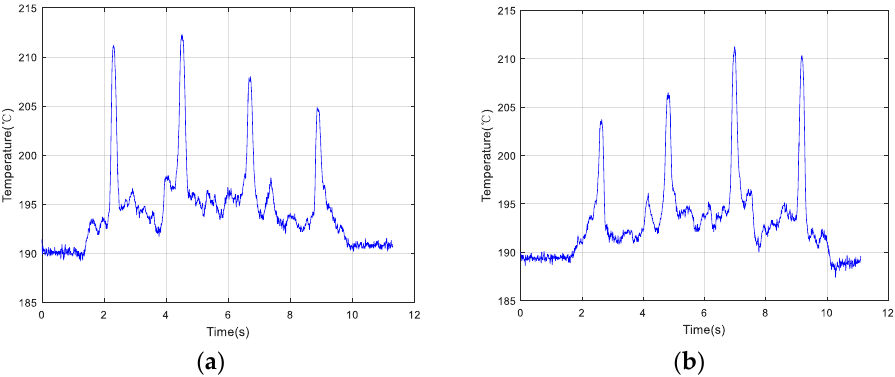
Figure 10. Collected temperature data of the four cracks scanned by an optical head at 5.0 mm/s along the ( a ) positive direction and ( b ) opposite direction.